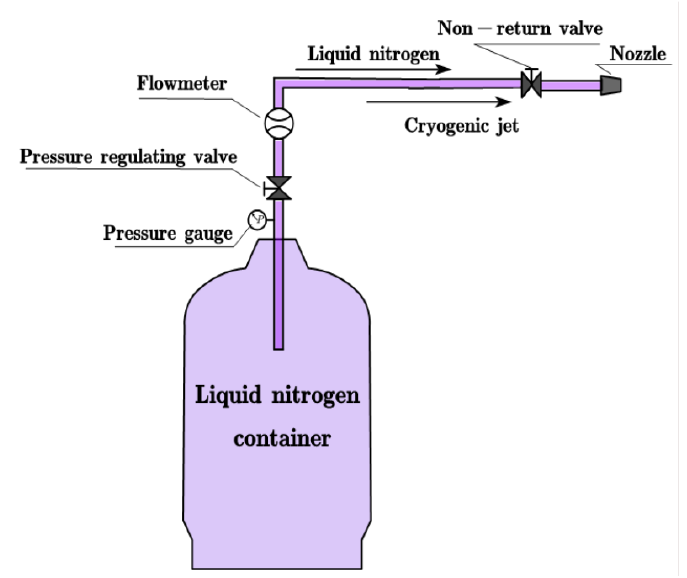
Figure 4. Cryogenic system.